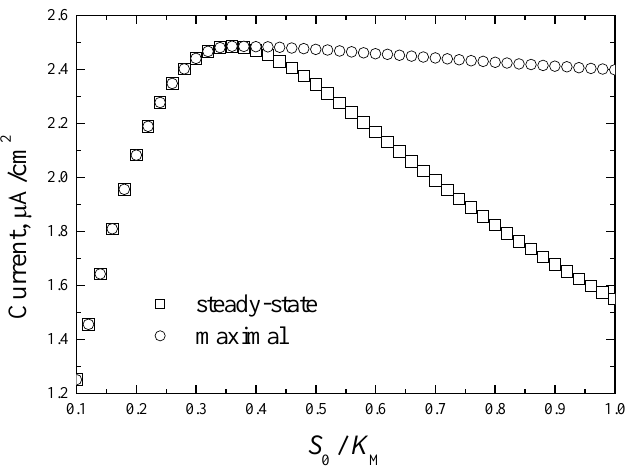
/ K values, V = 100 µ M/s, d = 20 µ m. 0 M max